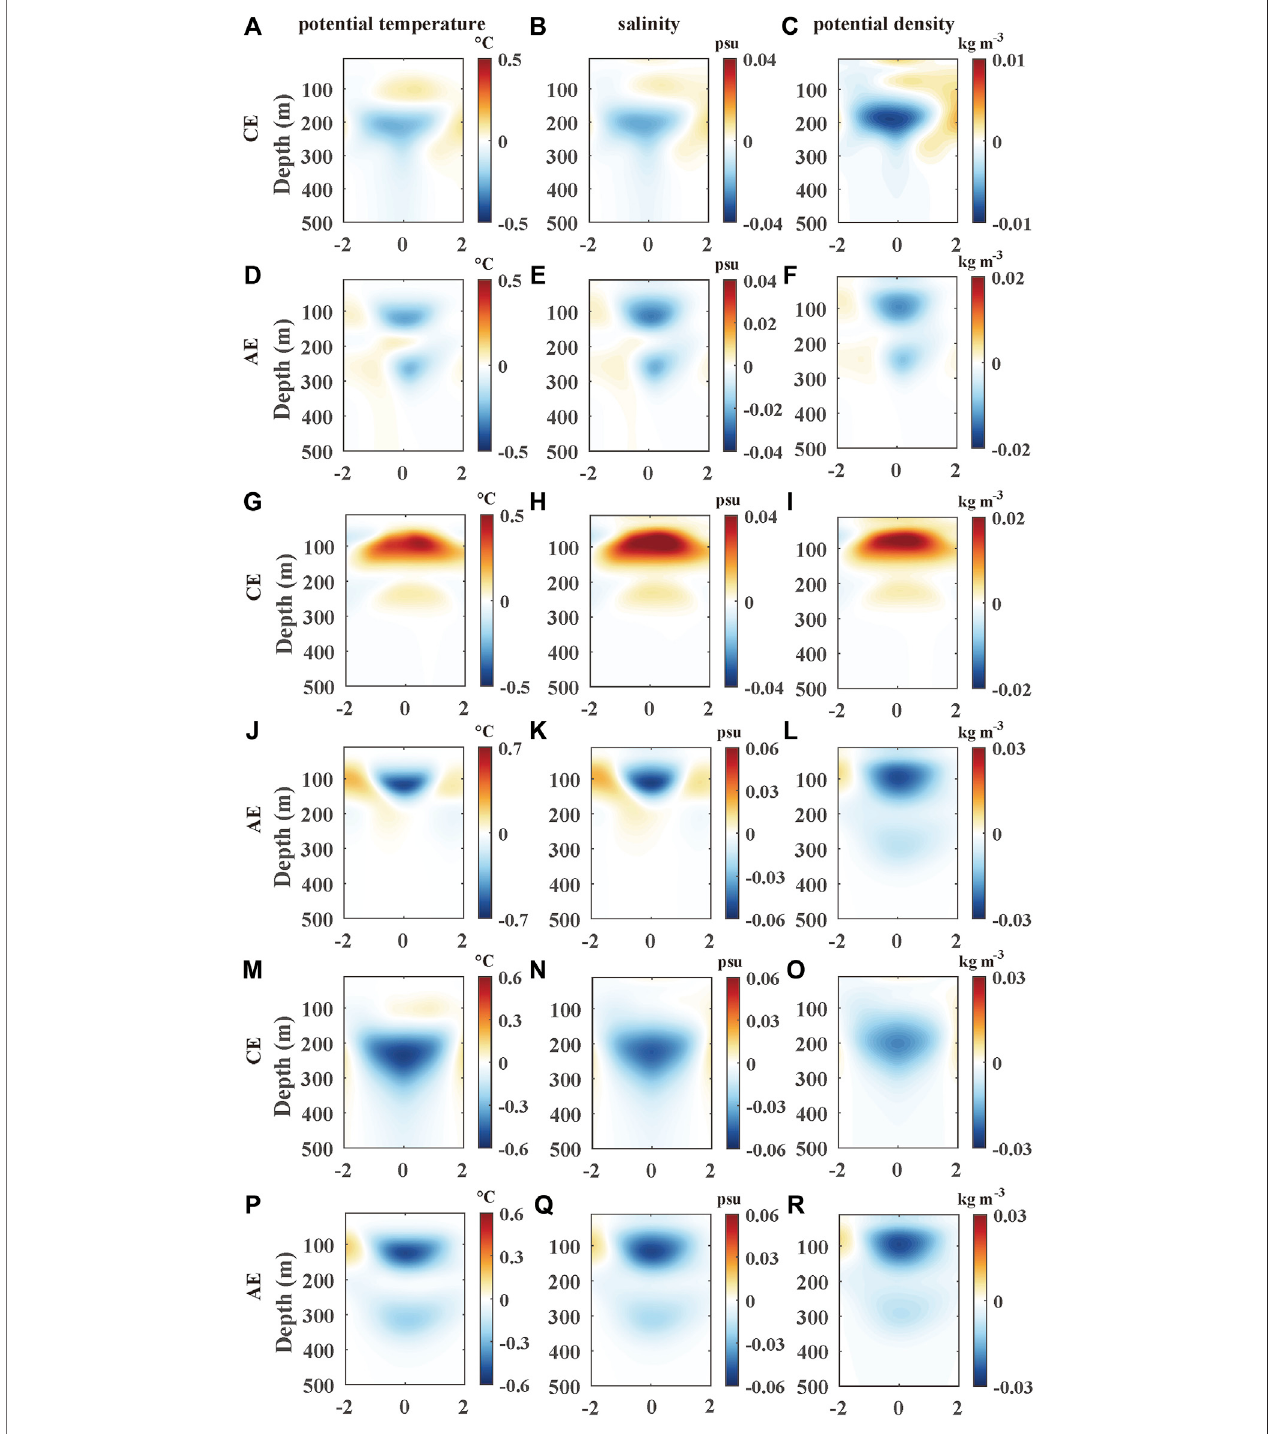
FIGURE 7 | (A) The zonal cross-section of the potential temperature ( ° C) anomalies of the composite eddy of the CE across the eddy center in the CTRLRUN. (B) Sameas (A) ,butforthesalinity(psu)anomalies. (C) Sameas (A) ,butforthepotentialdensity(kgm − 3 )anomalies. (D – F) Sameas (A – C) ,butforthecompositeeddyofthe AEat100 mdepthintheCTRLRUN. (G – L) Sameas (A – F) ,butforthecompositeeddiesoftheCEandtheAEintheSEASONRUN-Weak. (M – R) Sameas (A – F) ,butfor the composite eddies of the CE in the SEASONRUN-Strong.